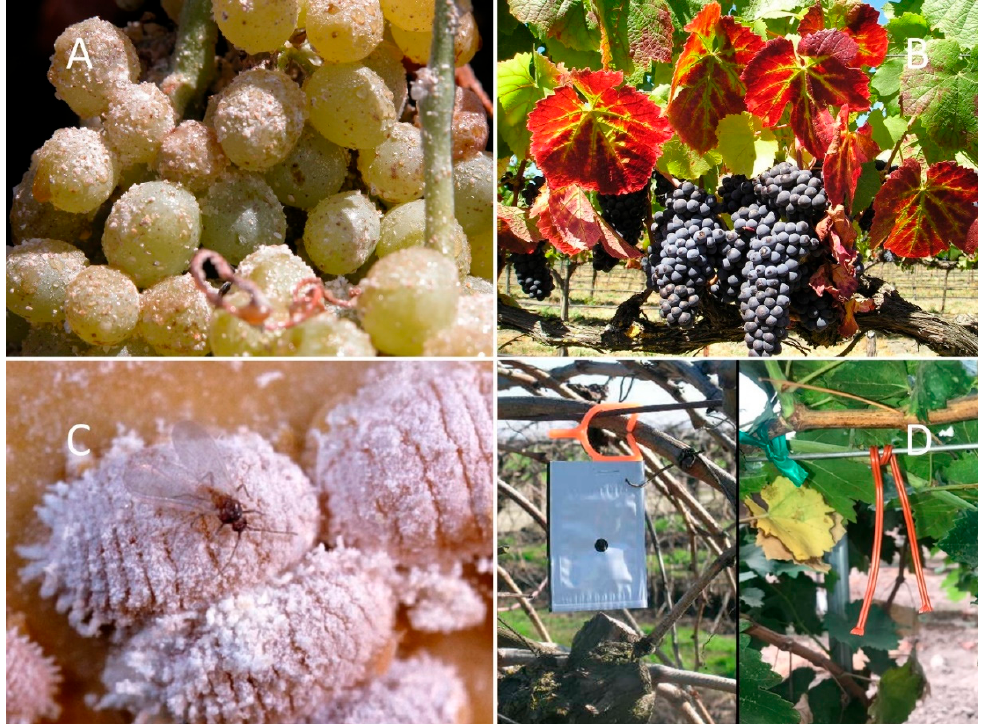
Figure 1. Planococcus ficus is one of the more important vineyard pests globally; shown here ( A ) damage to a table grape cluster from excessively high population density, ( B ) the reddened leaves symptomatic of grape leafroll disease (GLD) on a red-cultivar wine grape caused by grape leafroll-associated viruses transmitted by mealybugs, ( C ) mature female and an adult male Pl. ficus . and ( D ) the CheckMate dispenser (left) and Isomate rope dispensers (right) used in the studies described herein (note that commercial dispensers have gone through improvements since this work).